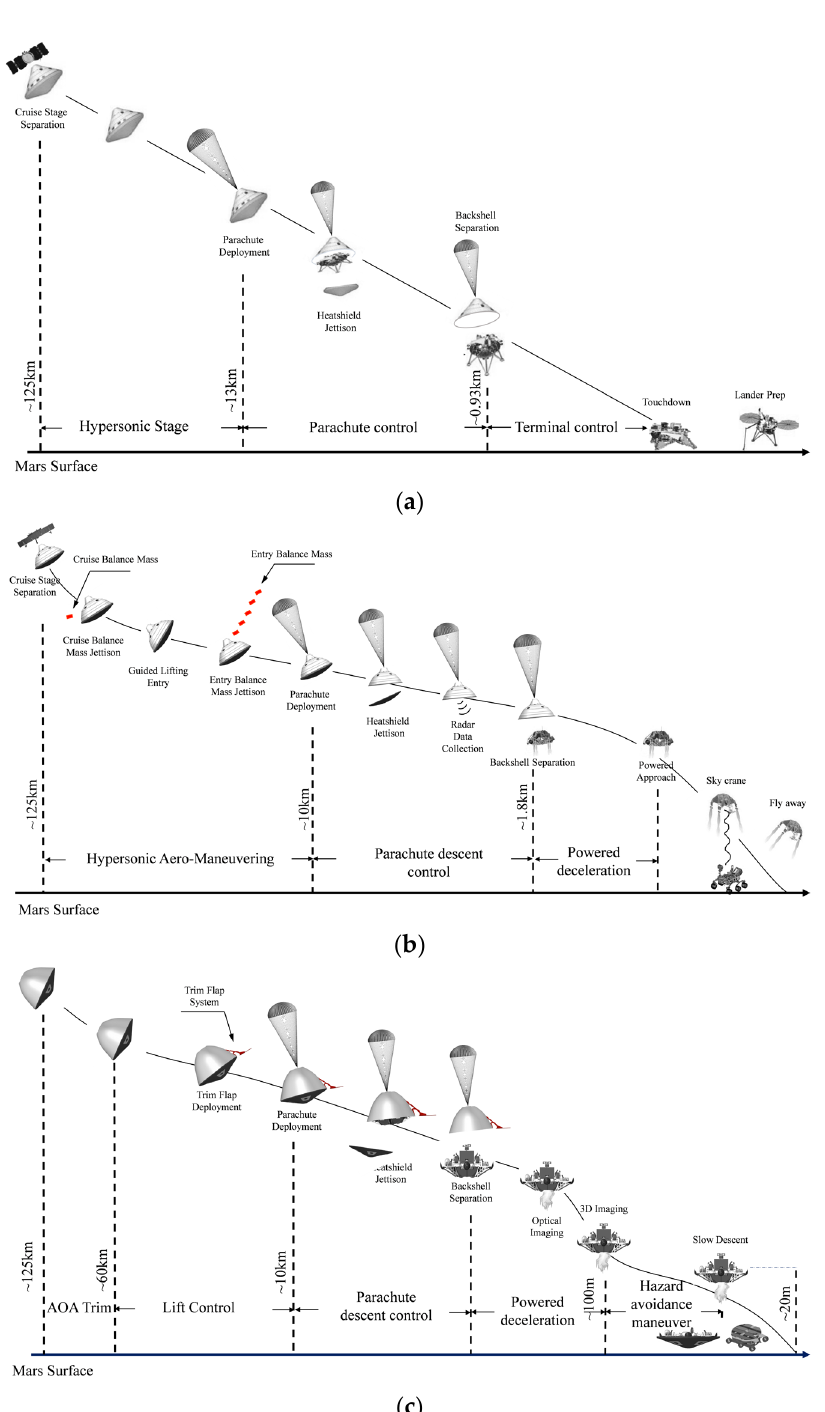
Figure 1. Sketch of three typical Mars entry, descent, and landing phases: ( a ) Ballistic entry; ( b ) Bal- listic-lifting entry with the use of the center of gravity offset; ( c ) Ballistic-lifting entry with the use of the trim flap.